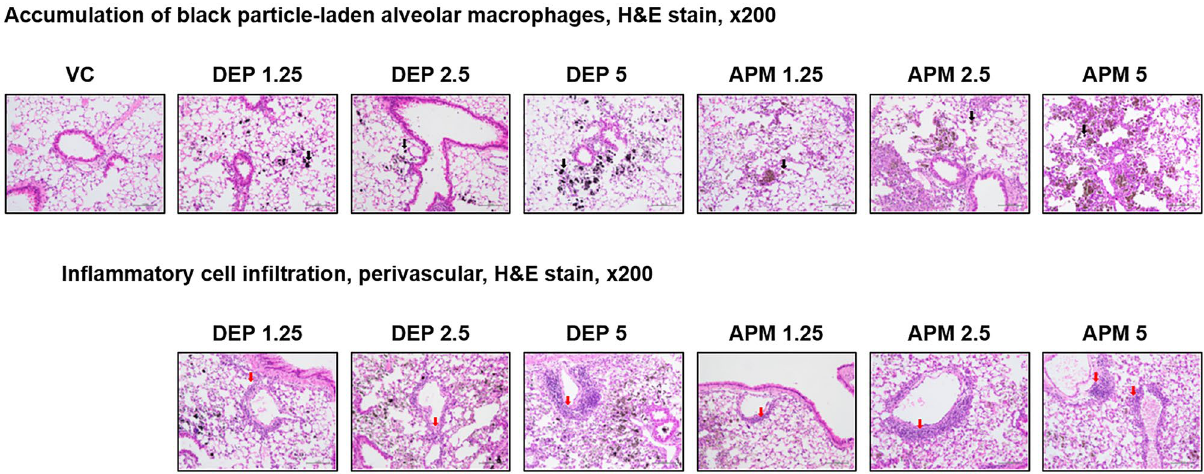
Figure 3. Histological changes in lung tissues upon DEP or APM exposure. Representative H&E-stained slides of lungs obtained from mice instilled with the vehicle, DEP, or APM. Black and red arrows indicate particle- pigment alveolar macrophages and inflammatory cell infiltration, respectively. DEP diesel exhaust particulate, APM artificial particulate matter, H&E hematoxylin and